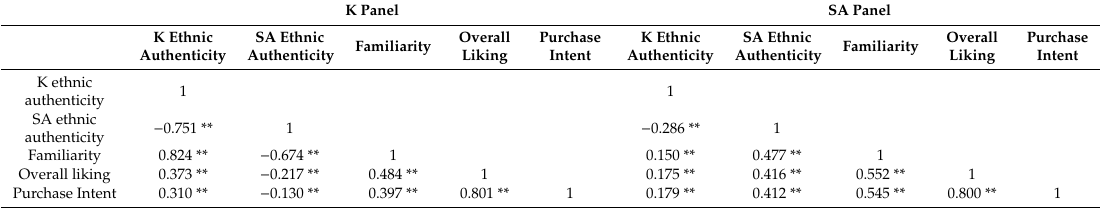
Table 5. Correlation coe ffi cients between dependent variables by the panels. K Panel SA Panel K Ethnic